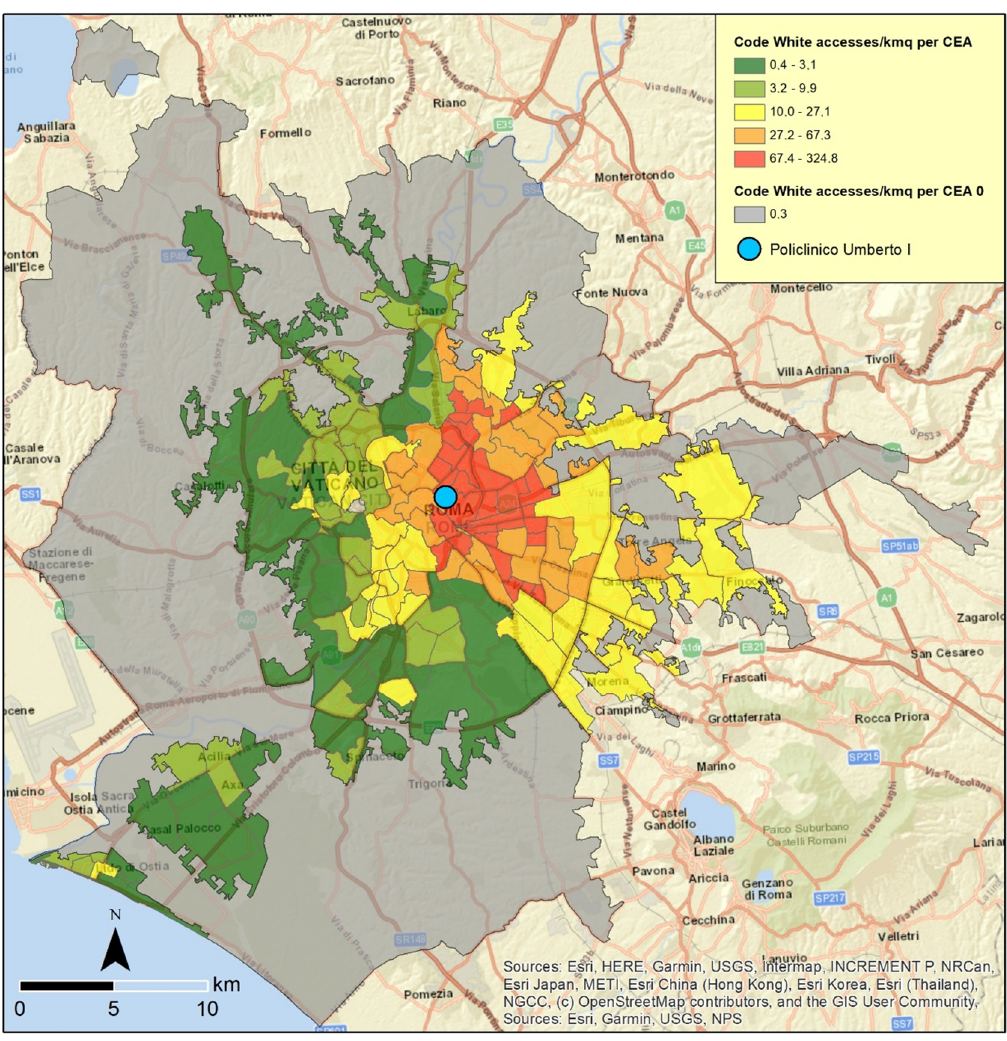
Figure 10. Accesses in code white recorded by the Policlinico Umberto I emergency room in relation to the surface, with data aggregated on the basis of census areas. Source: authors’ elaboration.